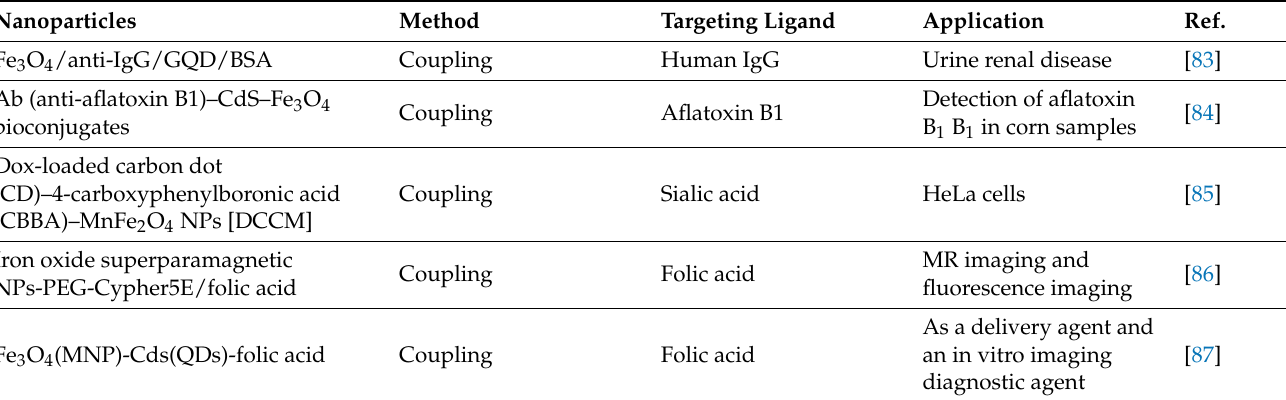
Table 1. Synthetic tailored magneto-fluorescent multimodal nanoparticles (NPs) and potential